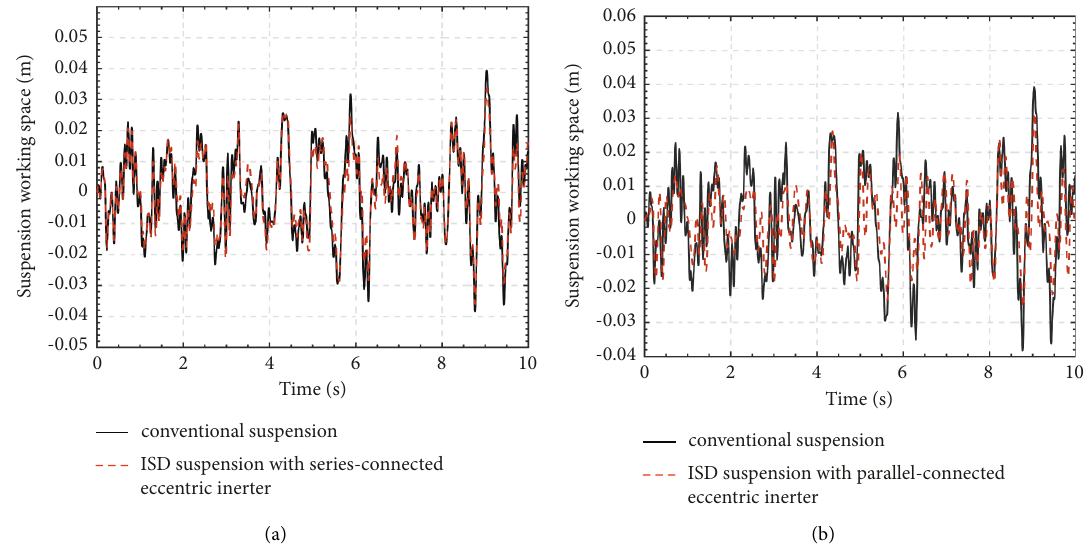
Figure 5: Responses of suspension working space in time domain.